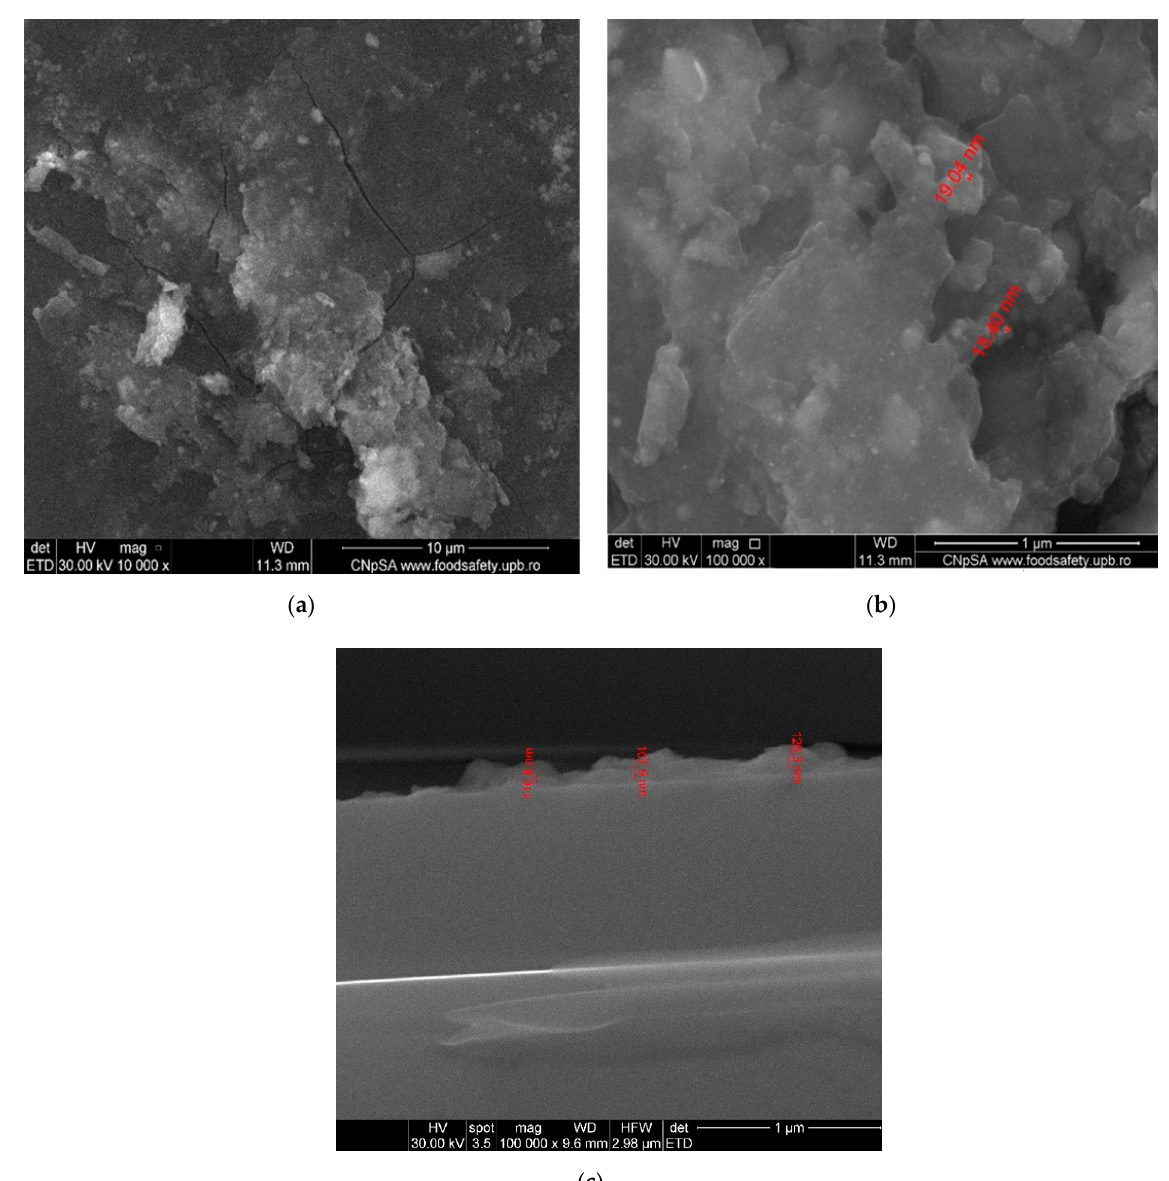
Figure 8. SEM micrographs of Fe 3 O 4 @CS/LyZ coating: ( a , b ) surface; ( c ) cross-section.